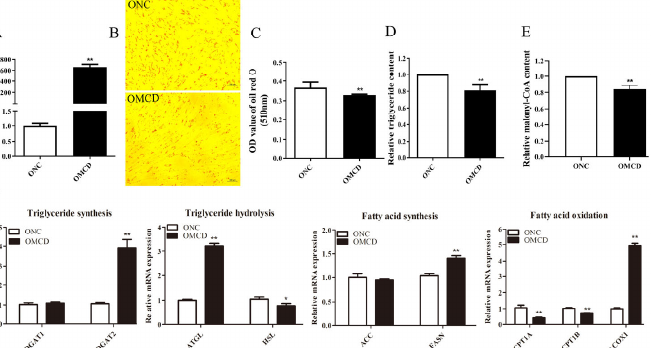
Figure 3. Overexpression of MCD inhibits fat droplet accumulation and triacylglycerol (TAG) synthesis in goat intramuscular preadipocytes. ( A ) MCD overexpression efficiency assay. ( B ) Cellular lipid droplets were observed through a microscope (100 μ m) after using Oil Red O staining. ( C ) The OD assay was performed at 510 nm by dissolving Oil Red O stain with isopropyl alcohol. ( D ) Effect of overexpression of MCD on intracellular TAG content. ( E ) Detection of intracellular malonyl ‐ CoA levels by ELISA. ( F ) Effect of overexpression of MCD on mRNA levels of genes related to lipid metabolism. After transfection of pcDNA3.1 or pcDNA.3.1 ‐ MCD into cells for 48 h, RT ‐ qPCR assays were performed. Data are presented as “Means ± SD”, n = 3. ** p < 0.01, * p < 0.05. ONC: pcDNA3.1 treatment as control; OMCD: pcDNA3.1 ‐ MCD treatment.